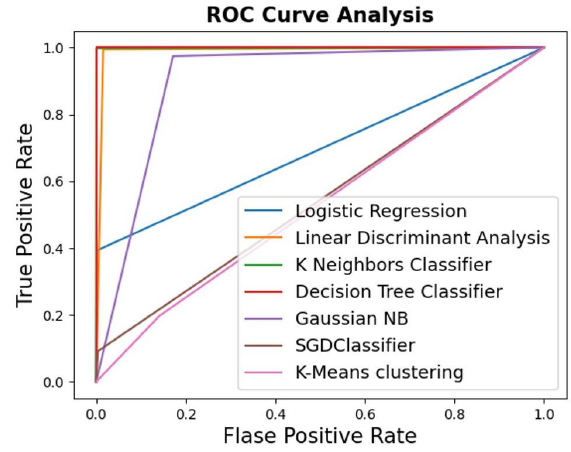
Figure 19. The ROC curves of ML models for